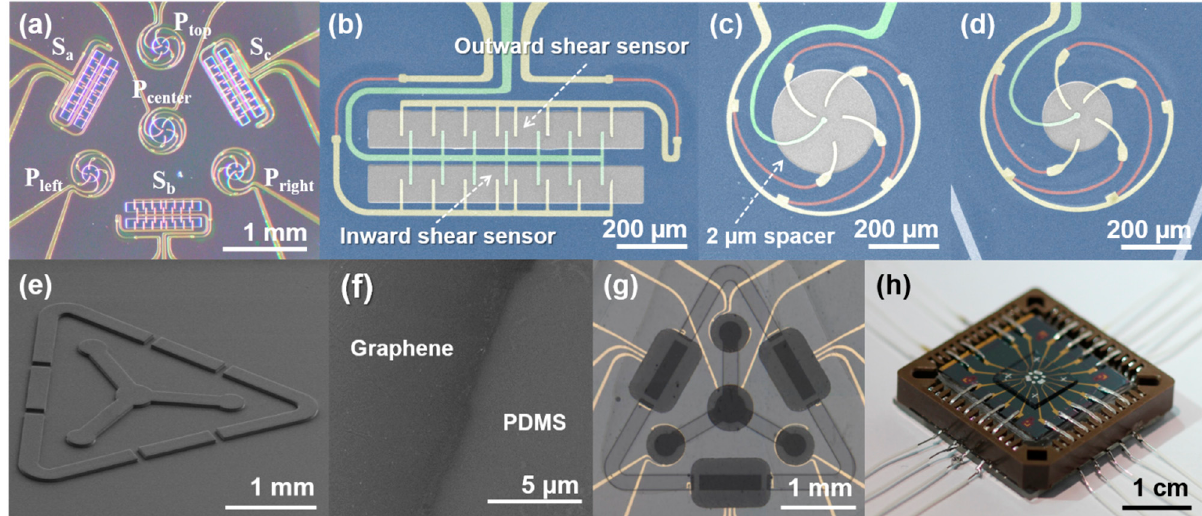
Figure 3. The image of the fabricated TIS: ( a ) an optical image of the bottom substrate with four pressure sensor units (P center , P top , P left , and P right ) and three shear sensor units (S a , S b , an S c ); the false color SEM image of ( b ) a shear sensor unit and pressure sensor units with ( c ) 200 μ m and ( d ) 300 μ m pit diameter. Each sensor is composed of (yellow) contact electrodes, (red) resistors, (green) ground electrode, and (blue) spacer; ( e ) SEM image of the SU-8 ridge and bump structure on the top PDMS layer; ( f ) SEM image of the patterned graphene after transferring to PDMS; ( g ) an optical image of the TIS sensor after combining the top and bottom substrates; ( h ) the fabricated TIS after mounting in a chipset.